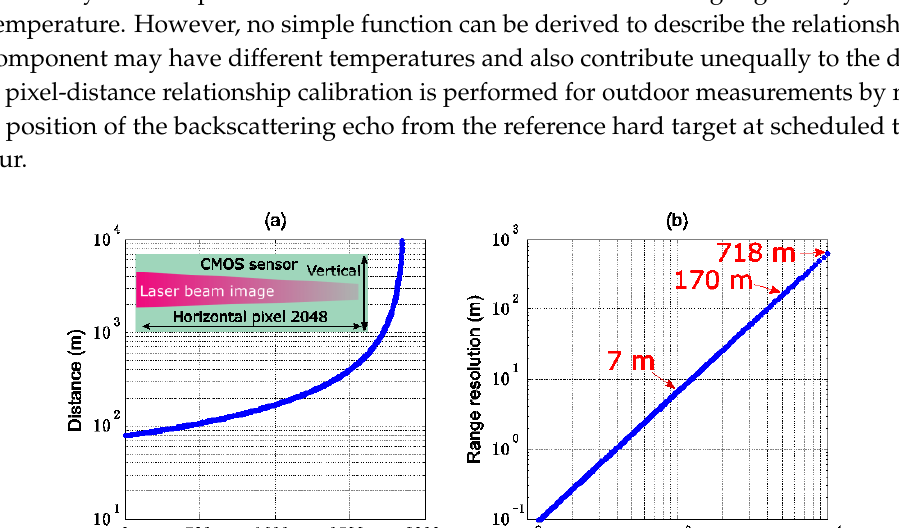
Figure 4. Temporal-spatial map of the ( a ) received signal intensity and ( b ) the atmospheric extinction coefficient. The measurements were performed on a near horizontal path with an elevation angle of 5 ° . Location of the lidar system: 38°52 ′ 46.4 ′′ N 121°31 ′ 42.1 ′′ E. The local times is 8 hours ahead of the Universal Coordinated Time (UTC). DN means digital number of the pixel intensity.